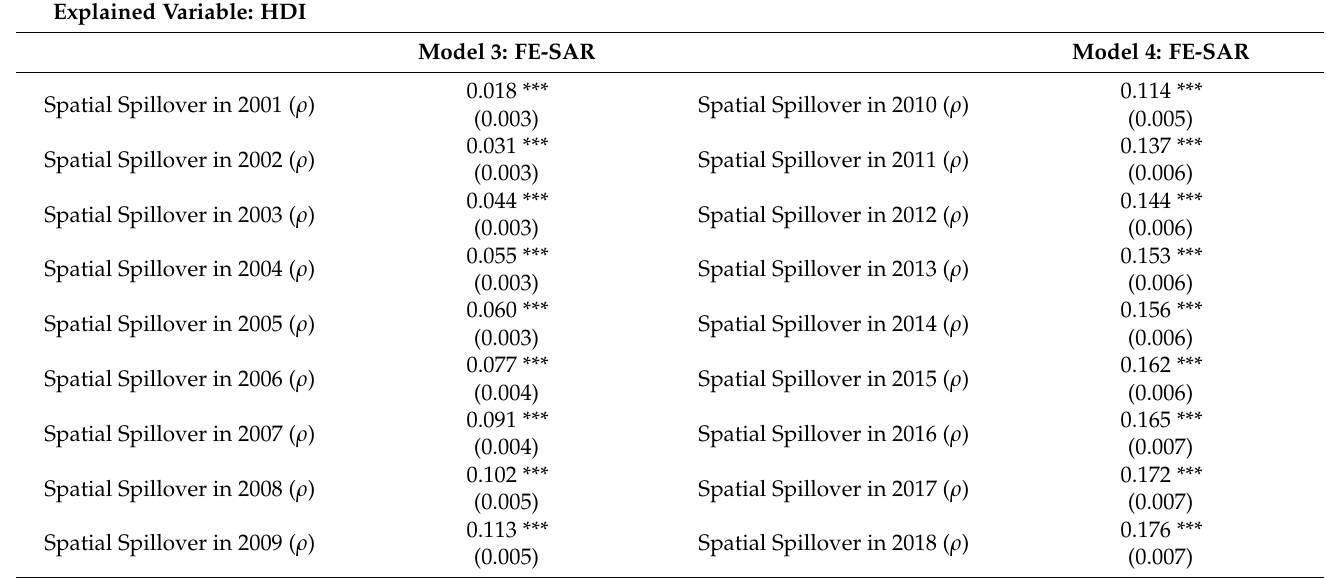
Table 3. Cross Section Estimation Results of the Spatial Spillover Effect of